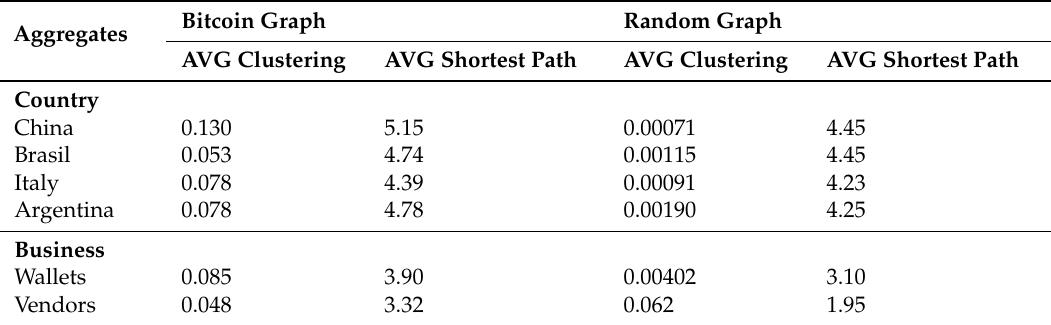
Table 5. Results of Investigating the Small World Phenomenon on